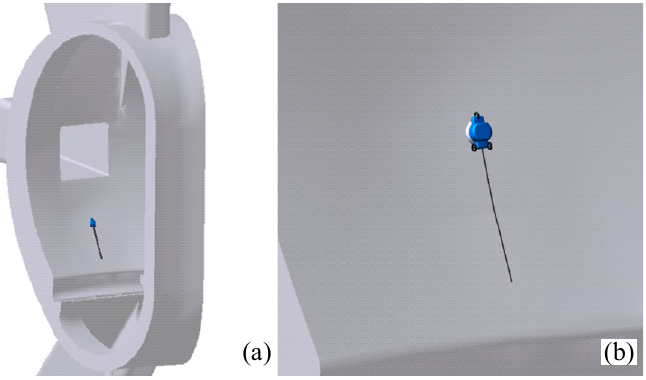
Figure 14. WMR simulation process. ( a , b ) The WMR moves on the interior walls of the vacuum chamber.